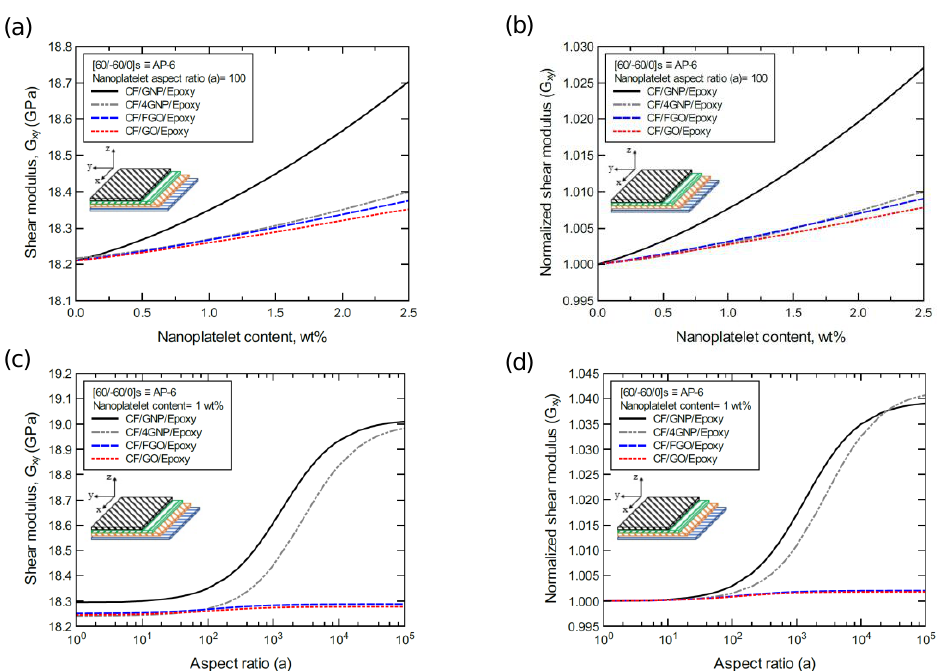
Figure 23. Comparison of the predicted in-plane shear modulus (G xy ) for a [60/-60/0]s (AP-6)-laminated composite plate based on the nanoplatelet type, content, and aspect ratio; ( a ) predicted G xy for various nanoplatelet contents at 100 aspect ratio, and the normalized response is shown in ( b ); ( c ) predicted G xy for various aspect ratio values at 1.0 wt% nanoplatelet content, and the normalized response is shown in ( d ). The volume fraction of CF is 56%.